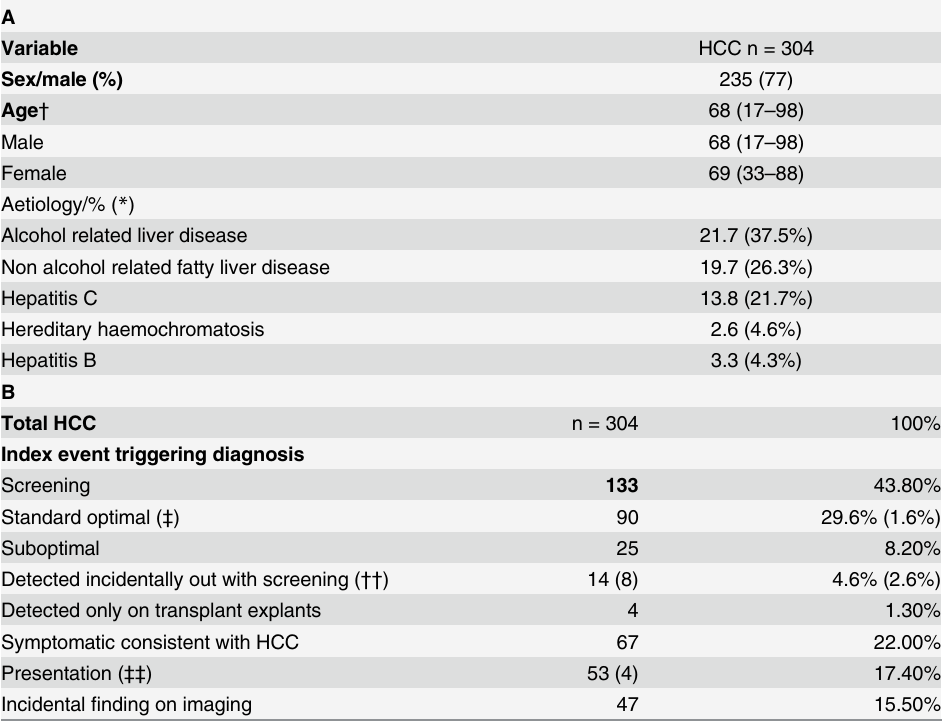
Table 1. Demographics and route to diagnosis in HCC